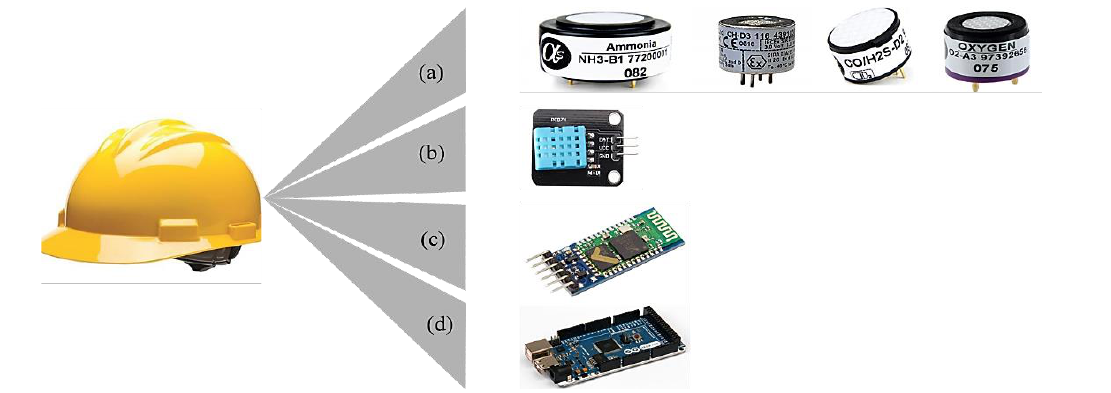
Figure 2. Components used to develop helmet-mounted monitoring system ( a ) Alphasense NH3-B1, CH-D3, CO/H2S-D2, O2-A3 gas sensors, ( b ) DHT11 temperature and humidity sensor, ( c ) HC-05 Bluetooth module, and ( d ) Arduino Mega.